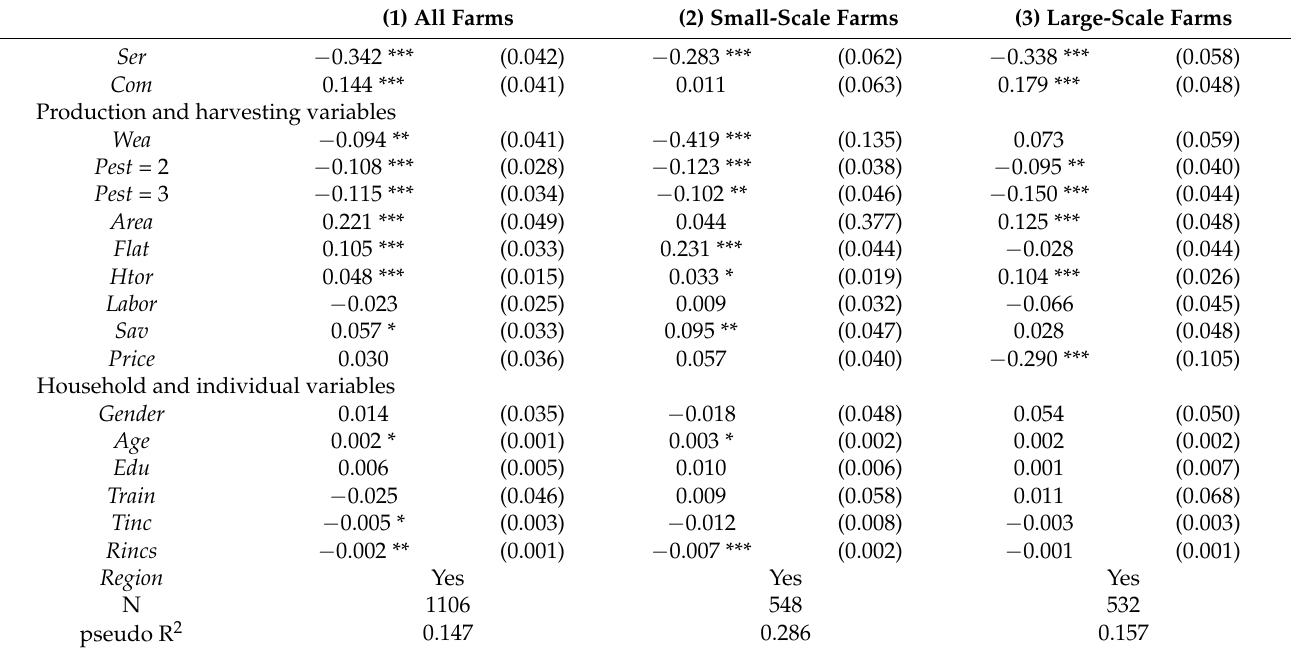
Table 3. Marginal effects without the cross